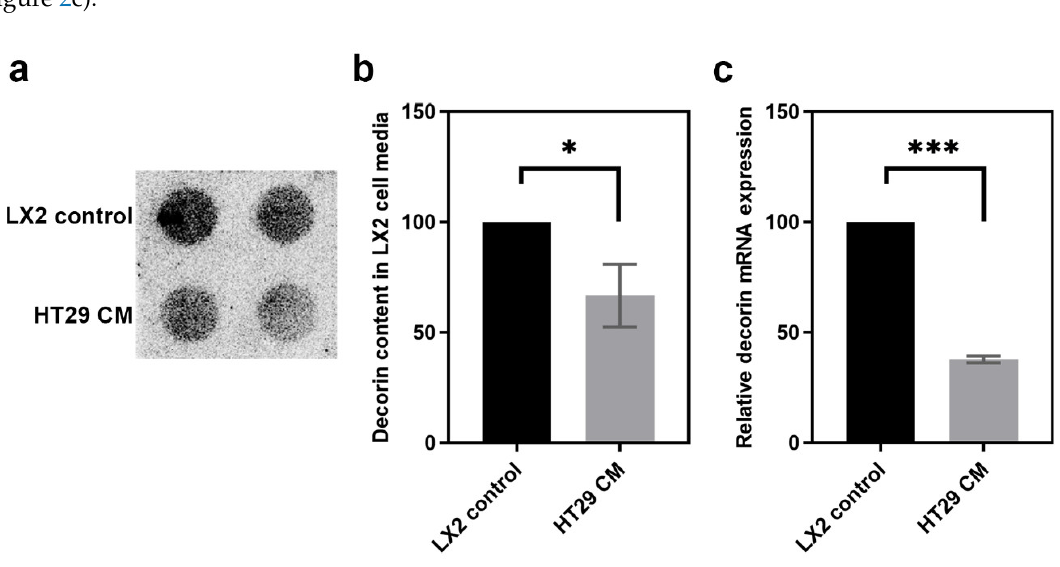
Figure 2. Decorin production in LX2 stellate cells upon exposure to HT29 human colon adenocarcinoma cell medium. Dot blot analysis of decorin content in LX2 cell media ( a ) and its quantification ( b ). Determination of decorin mRNA levels ( c ). CM = conditioned medium. Data are shown as mean (S.D.) *** p value < 0.001; * p value < 0.05.